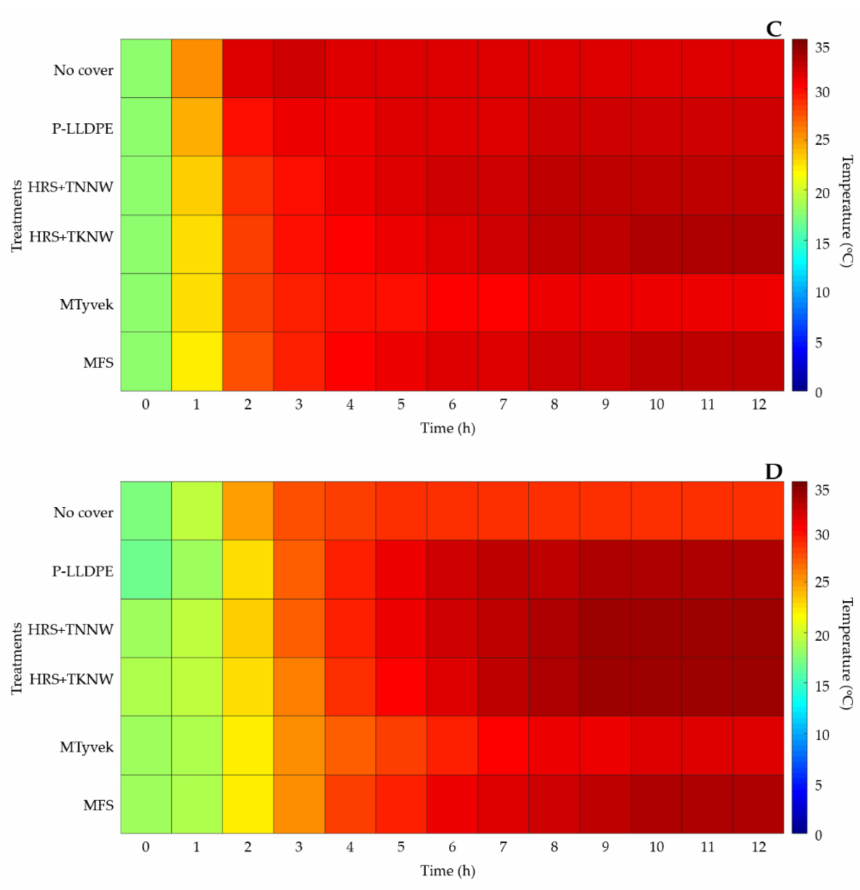
Figure 6. Heatmap chart of air ( A ) and pulp ( B ) temperature profiles during simulated storage at 18 ◦ C for 12 h. Air ( C ) and pulp ( D ) temperature profiles during simulated transportation at 30 ◦ C for 12 h.